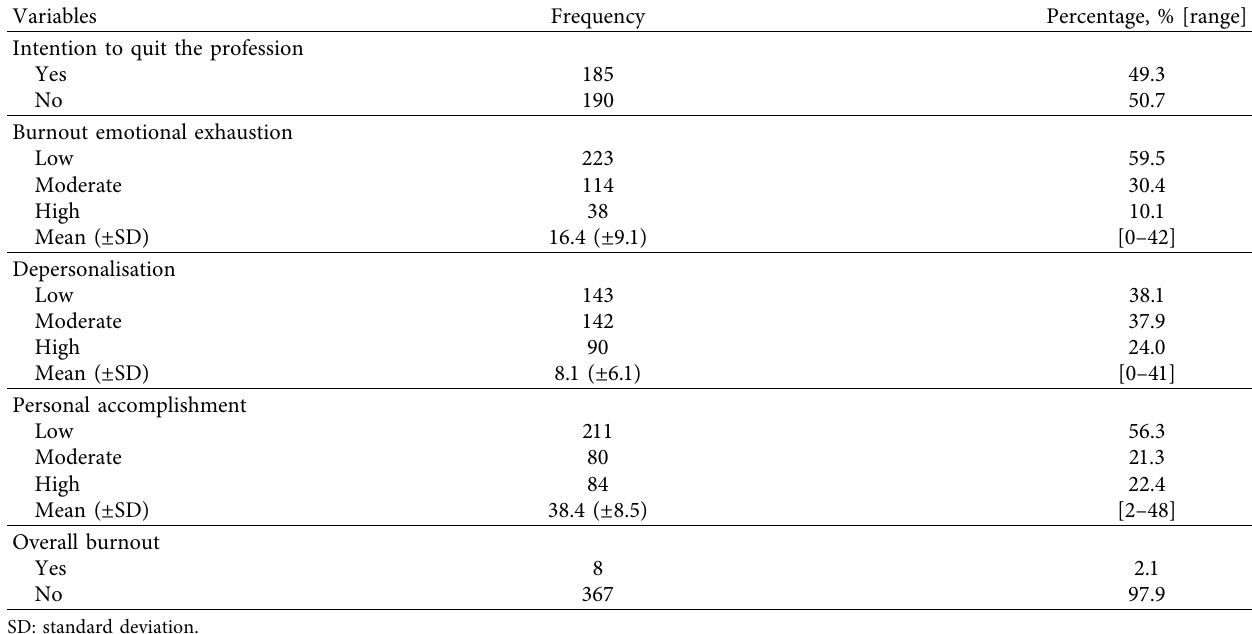
Table 2: Intention to quit the profession and burnout among participants.